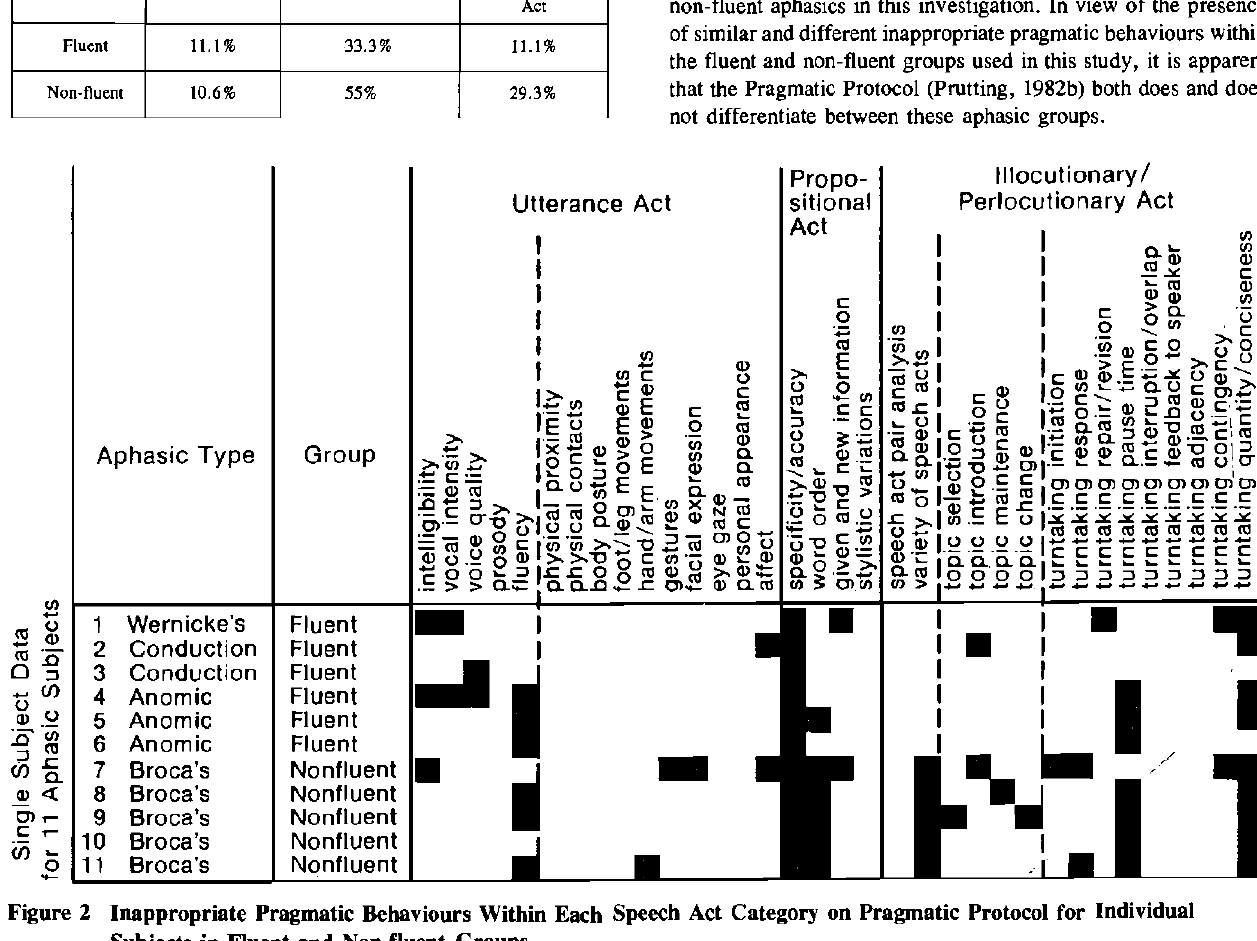
Table 3 Percentage of inappropriate pragmatic behaviours for fluent and non-fluent aphasics in each speech